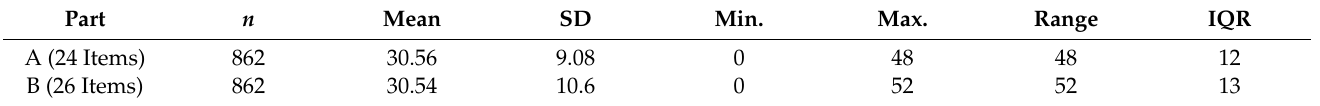
Table 1. Mean Total Score of Participants.